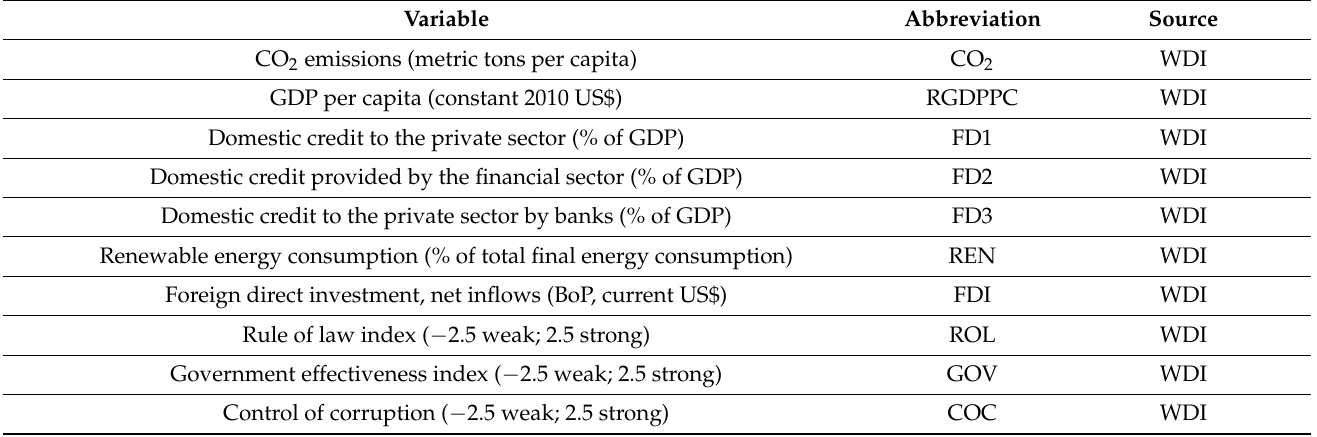
Table 1. Variable